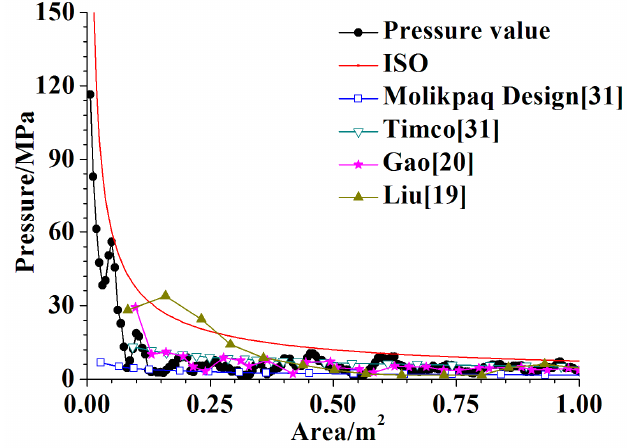
Figure 8. Comparison of pressure - area relationship between this study and other researchers. J. Mar. Sci. Eng. 2020 , 8 , 193 10 of 22